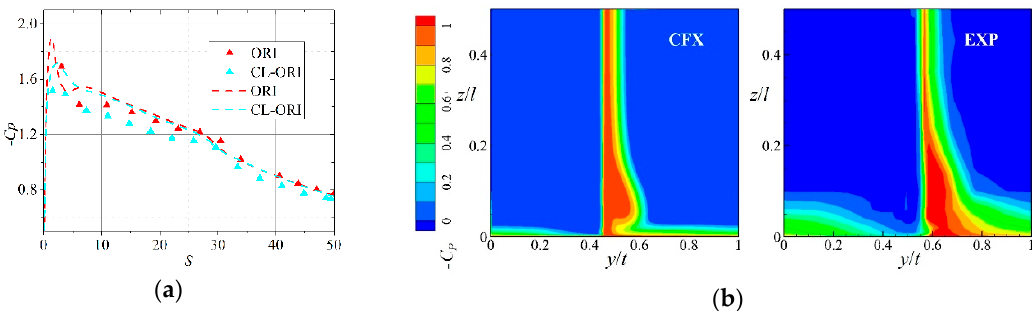
Figure 20. The verification of the simulation: ( a ) Cp distribution among the suction surface at 0.5 height of CL-ORI at Tu = 2.5%, Re t = 2500; ( b ) Cp contour at 1.1 chord length exit.